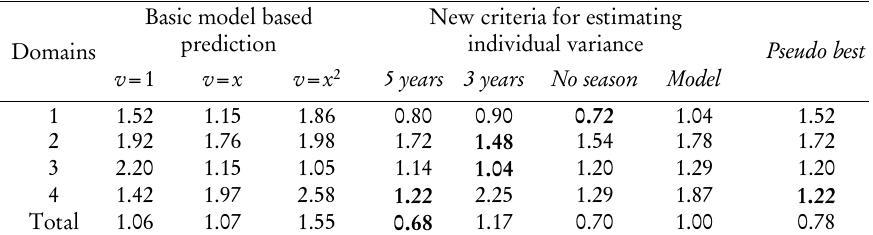
Comparison among MAPEs obtained through the use of the optimal model based predictor and different criteria for model unit variance estimation Mean of 4 quarters – Real data referred to 2010